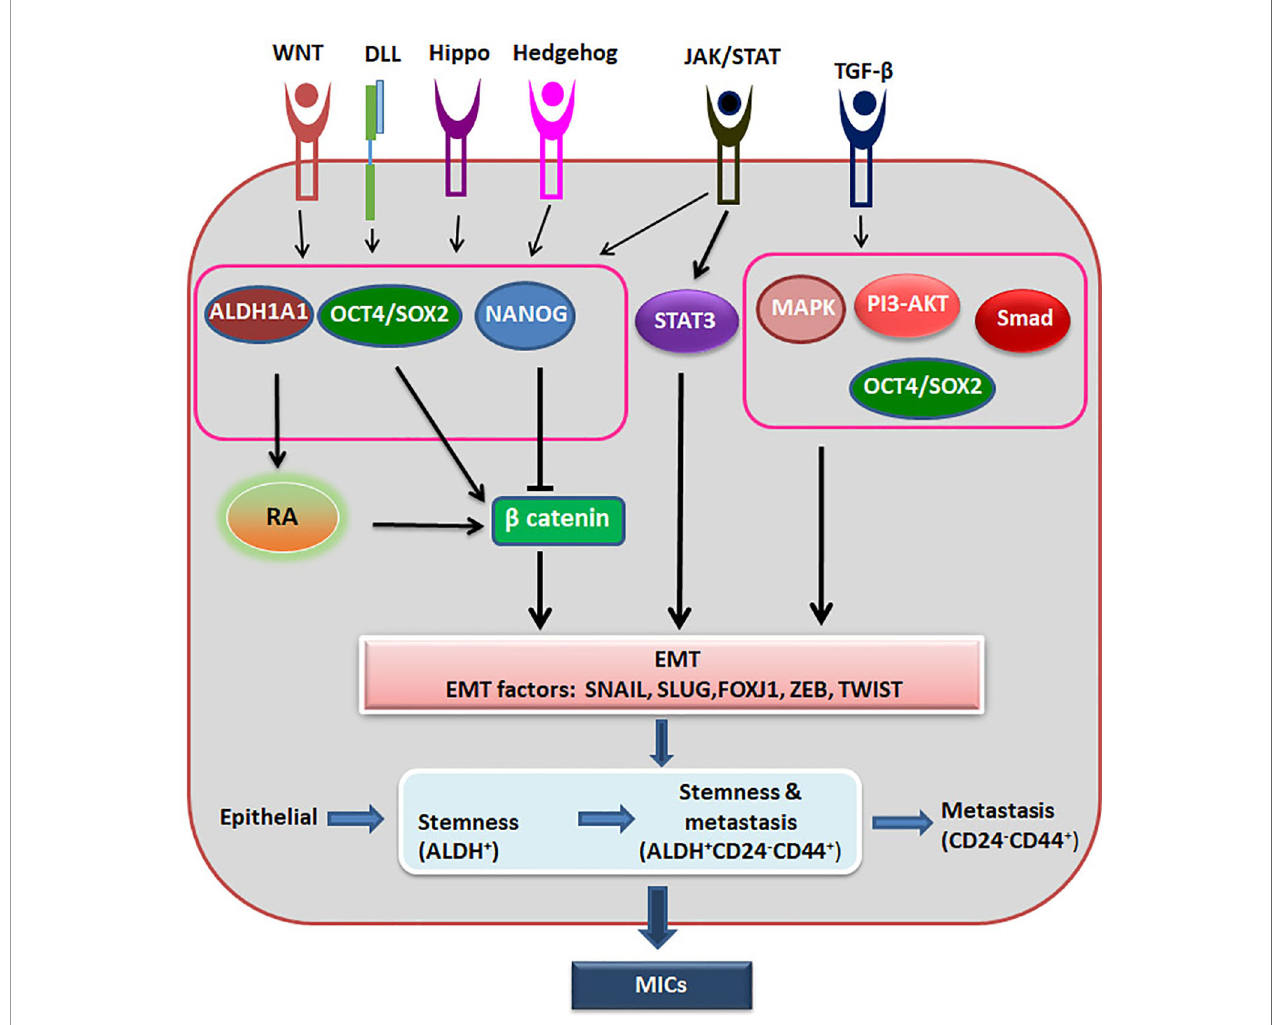
FIGURE 3 | The regulation of Metastatic CSCs. Different signaling pathways activate ALDH1A1, OCT4 and SOX2, which activates b -catenin to induce EMT. At the same time OCT4/SOX2 regulates EMT in a b -catenin independent way also. NANOG inhibits b -catenin, but activates EMT through other pathway. When there is induction of EMT, epithelial cells might acquire stemness and metastatic ability, and gradually lose the stemness. The hybrid cells showing stemness property and metastatic property together are the metastasis initiating cells